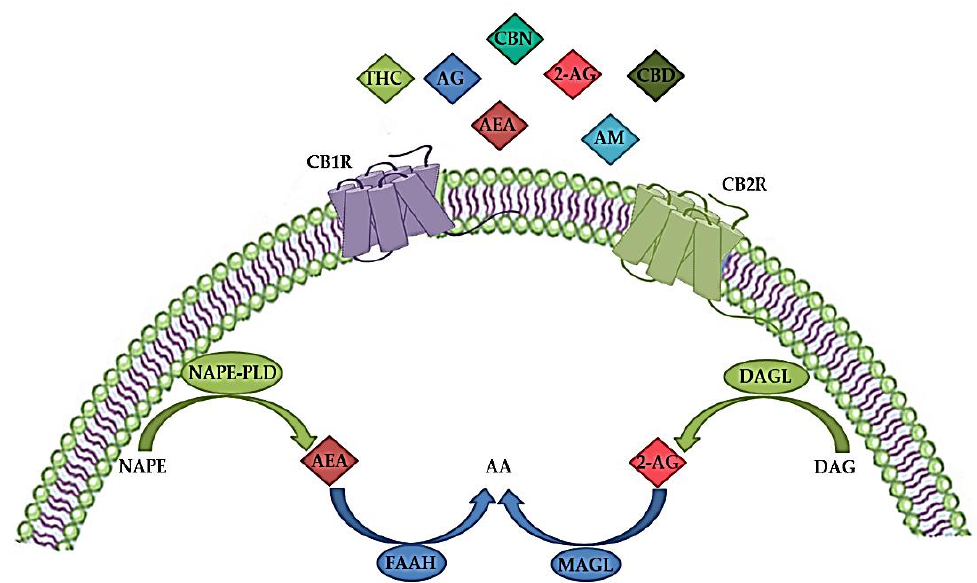
Figure 1. The endocannabinoid system (ECS) consists of endogenous cannabinoids (endocannabinoids) such as anandamide (arachidonoylethanolamide, AEA) and 2-arachidonoylglicerol (2-AG), anabolic enzymes (N-acylphosphatidylethanolamine-hydrolyzing phospholipase D (NAPE-PLD) and 1,2-diacylglycerol lipase (DAGL)), catabolic enzymes (fatty acid amide hydrolase (FAAH) and monoacylglycerol lipase (MAGL)) and cannabinoid receptors 1 (CBR1) and 2 (CB2R). In addition to endocannabinoids, various exogenous natural cannabinoids (phytocannabinoids), such as tetrahydrocannabinol (THC), cannabidiol (CBD) and cannabinol (CBN), as well as synthetic cannabinoids, such as different agonists (AG) or allosteric modulators (AM) act via CBR1 and/or CB2R. AA — arachidonic acid; DAG — diacylglycerol; NAPE — N-acylphosphatidylethanolamine. The image was created using Microsoft PowerPoint 2016.